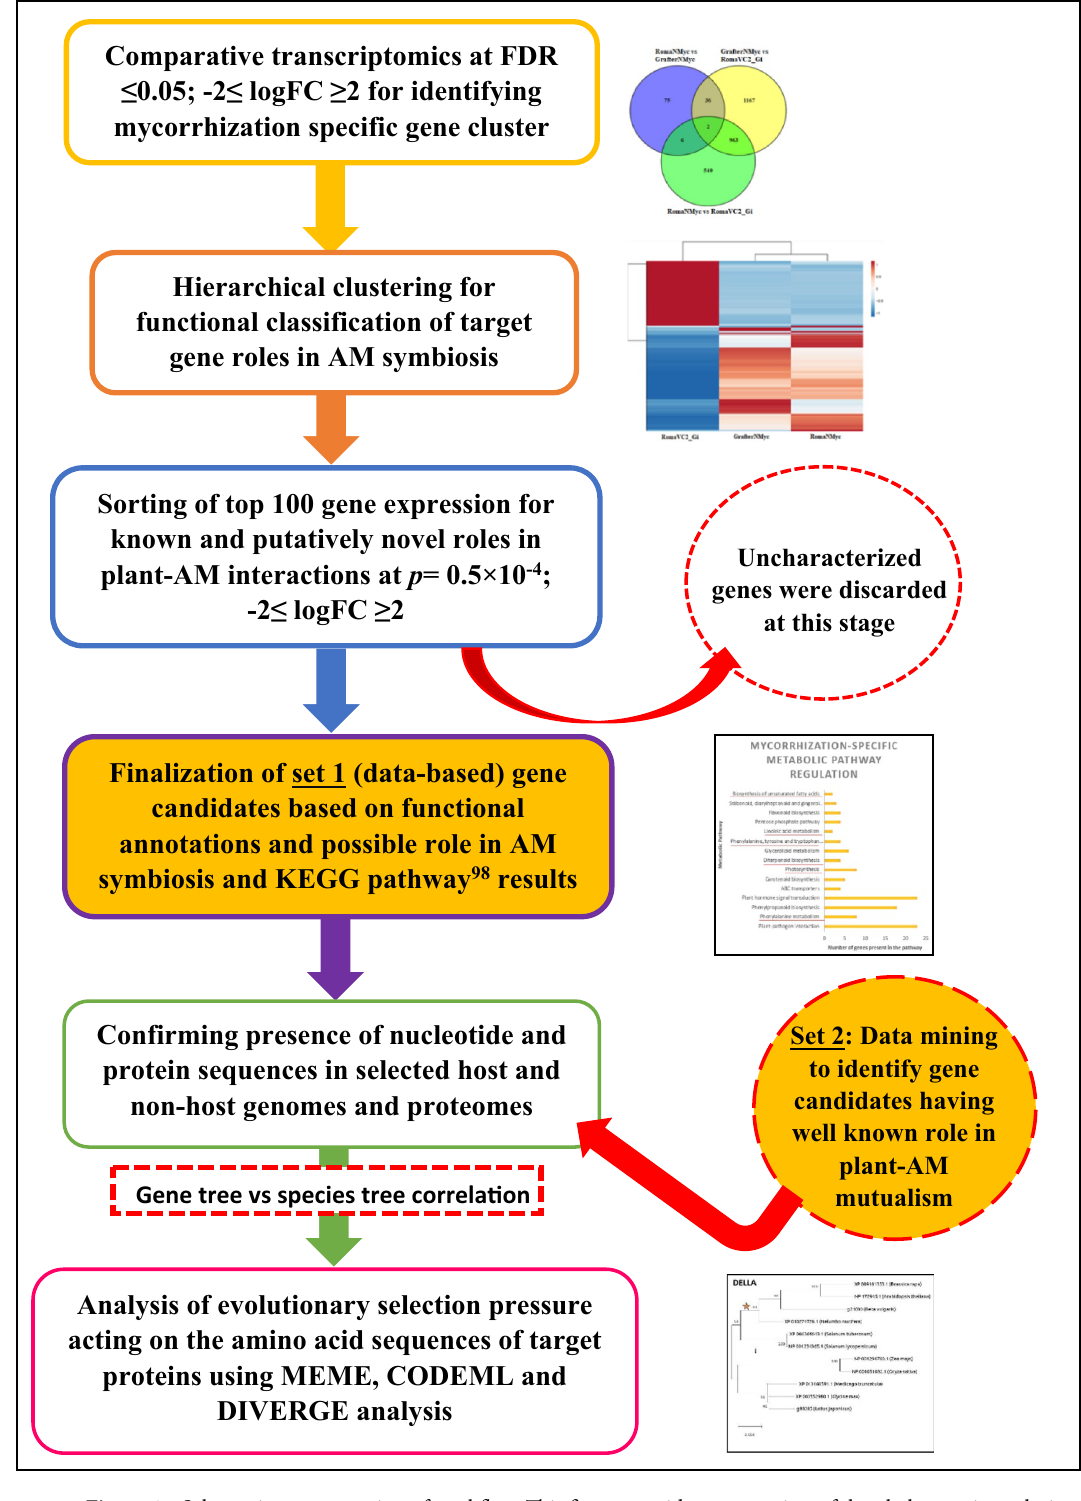
Figure 1. Schematic representation of workflow. This figure provides an overview of the phylogenetic analysis workflow adapted in this study. The images accompanying methods are representative examples of results obtained. These are enlarged/explained in “Results”